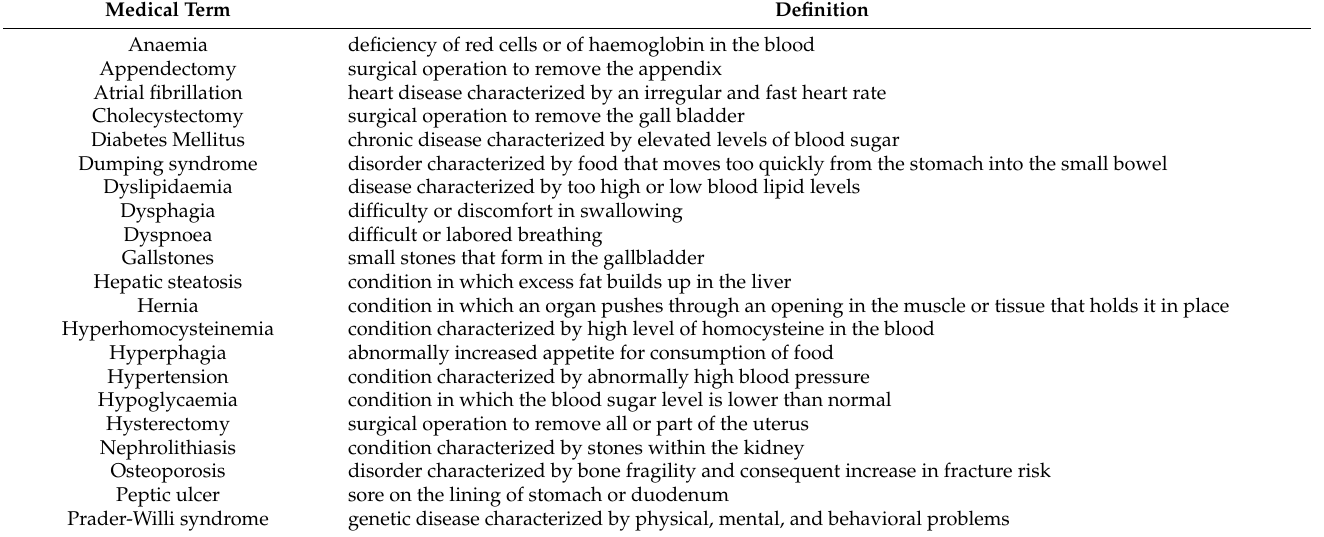
Table 1. Glossary of symptoms and medical conditions related to the “Bariatric Surgery”